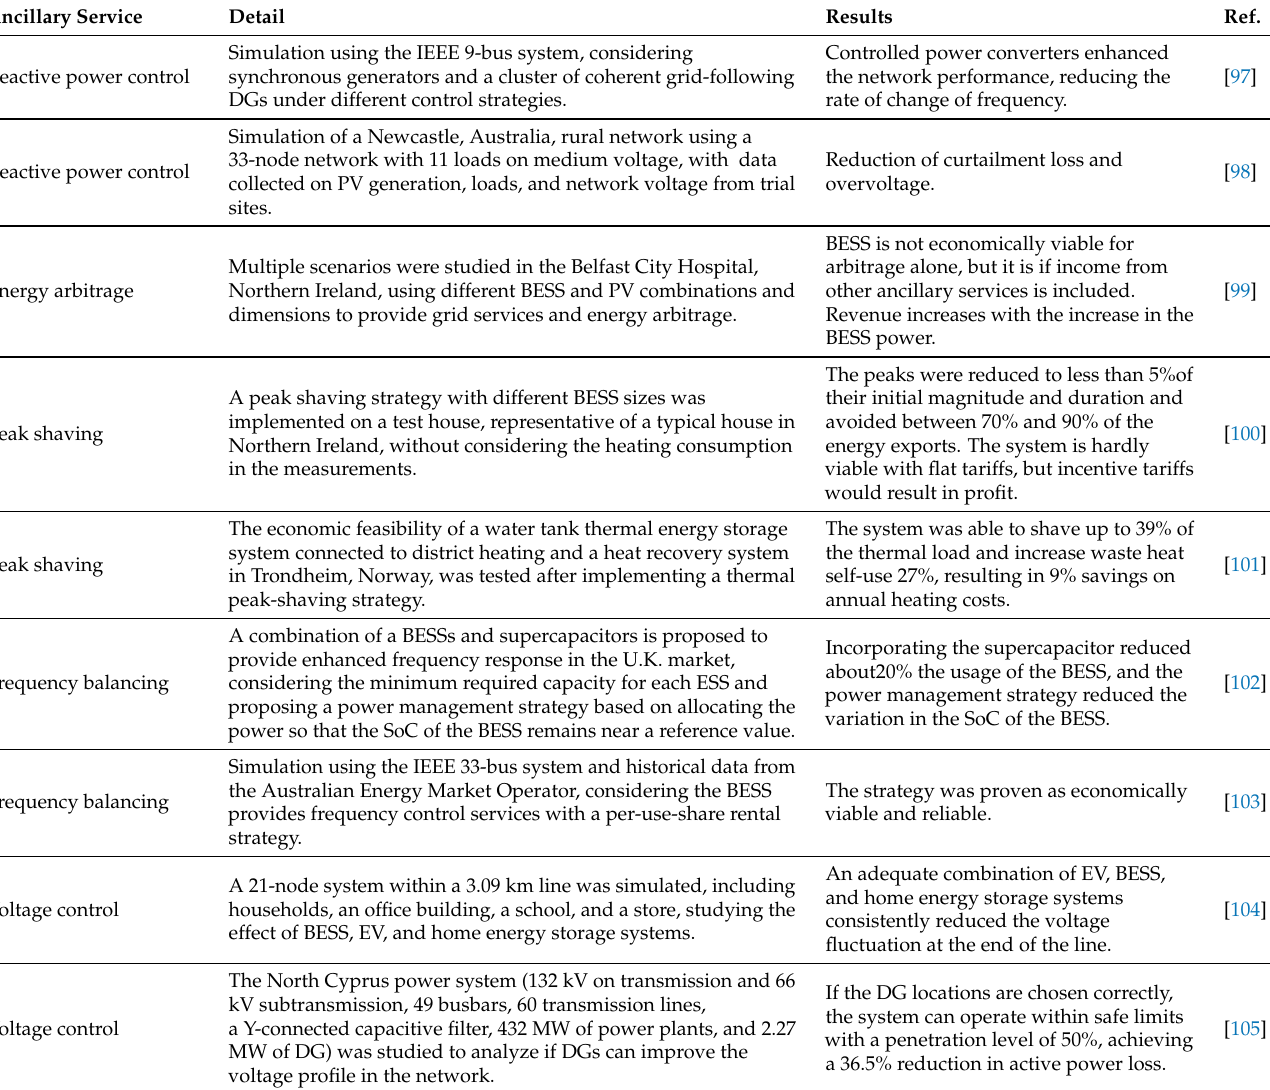
Table 3. Representative cases of reported outcomes of ancillary services through DG